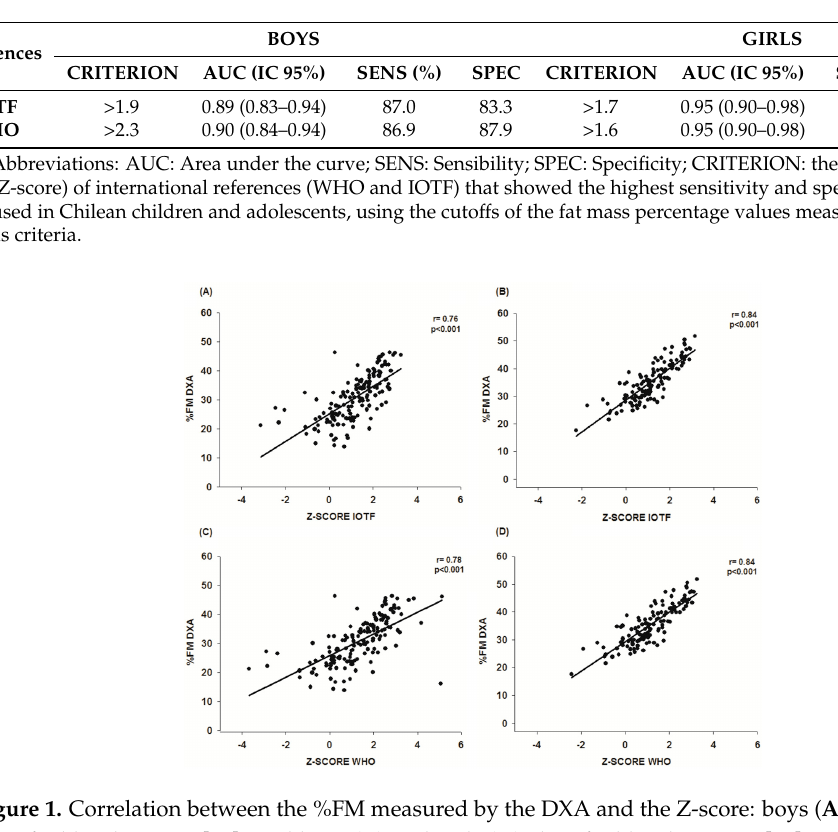
Table 3. Descriptive values of the ROC Curve in both sexes.